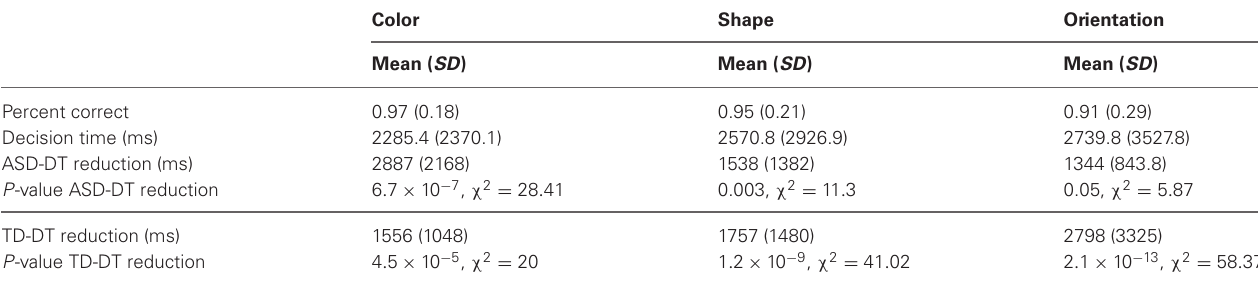
Table 1 | Systematic changes in cognitive decision-making performance occurring in parallel with motor (speed) learning.